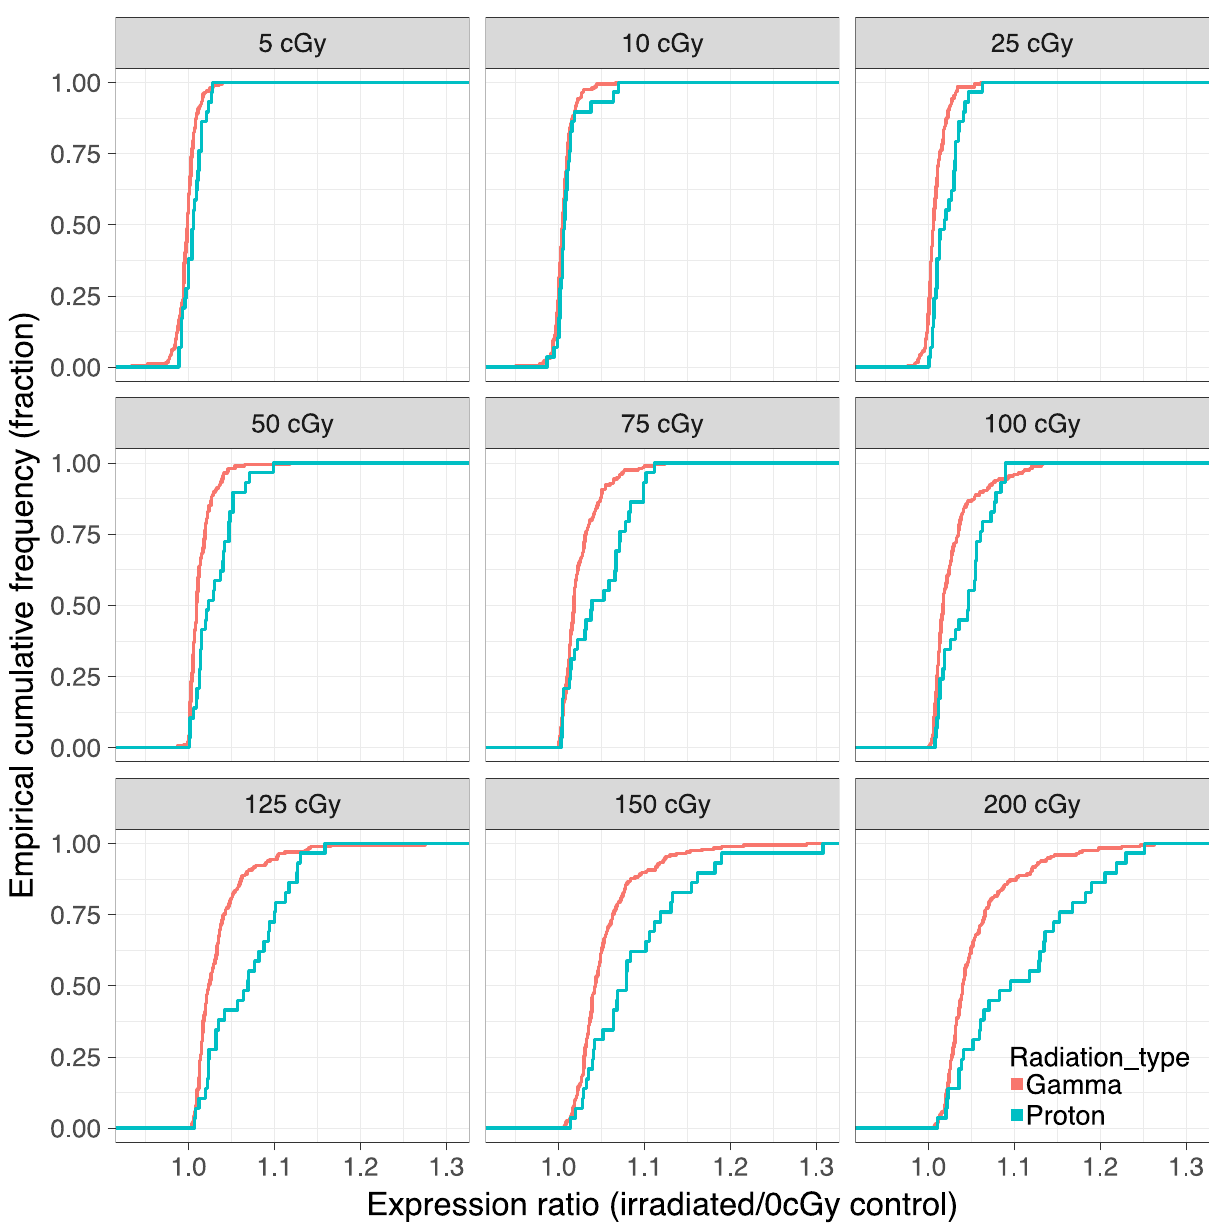
Fig 3. Comparison of the dose response. Empirical cumulative frequency distributions of the gene expression ratios (gene expression at each physical dose over the gene expression at 0 cGy) are plotted for gamma and proton radiation.